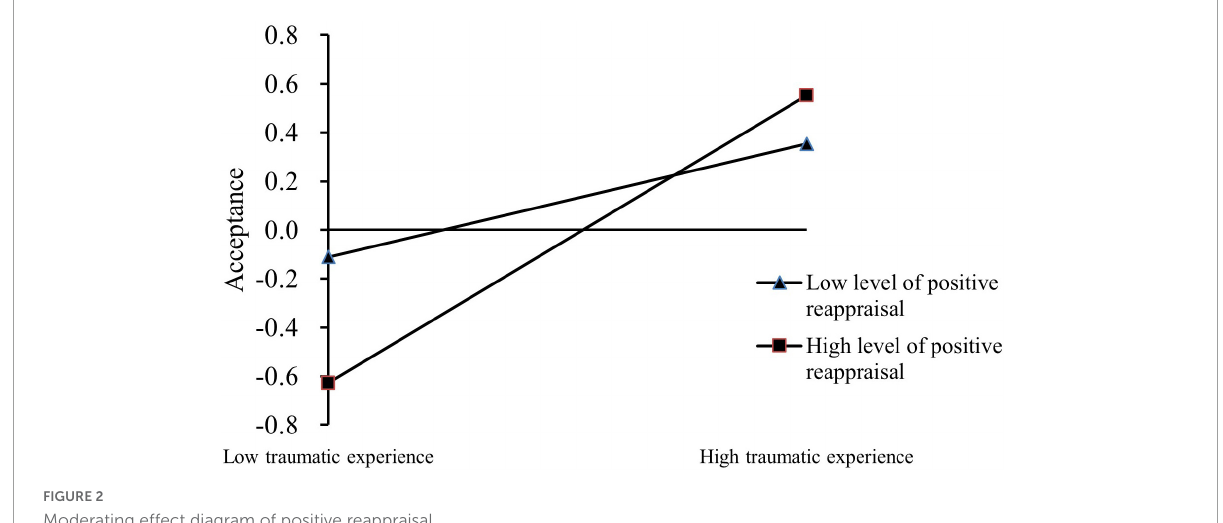
FIGURE2 Moderating effect diagram of positive